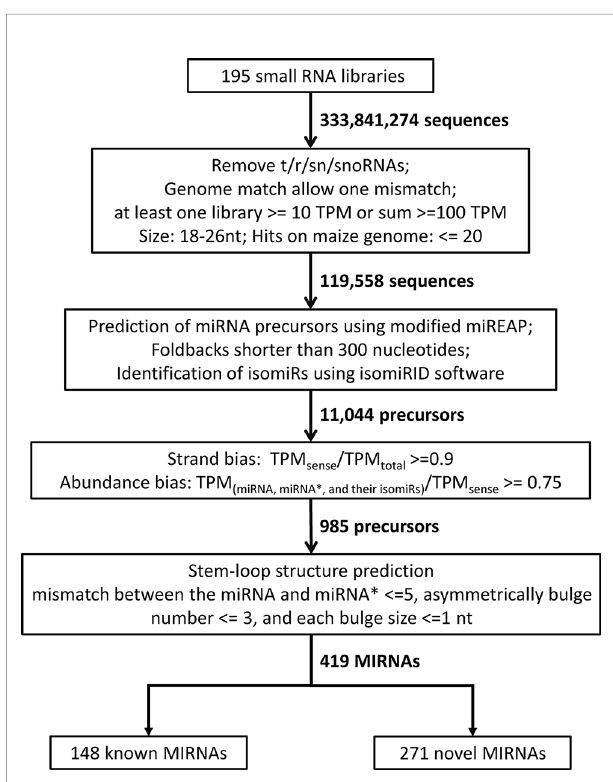
FIGURE 1 | Bioinformatics pipeline for the identi fi cation of miRNA genes in